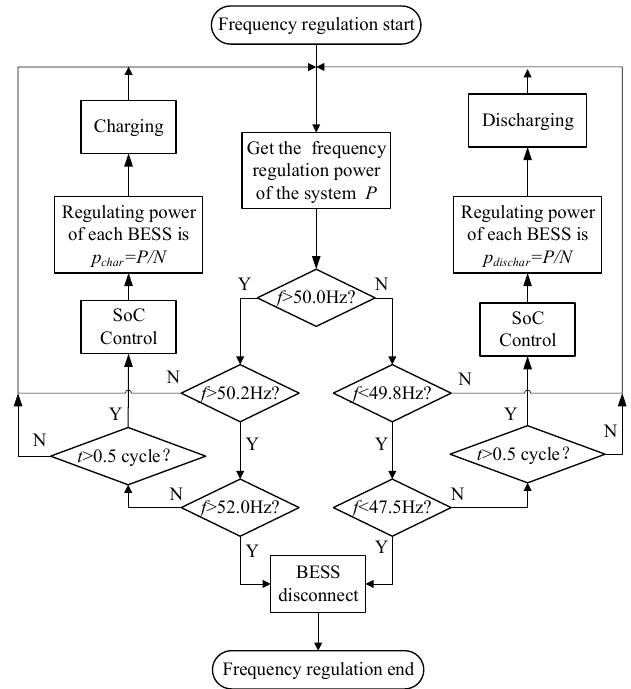
Figure 5. Battery energy storage systems (BESS) frequency regulation block diagram.